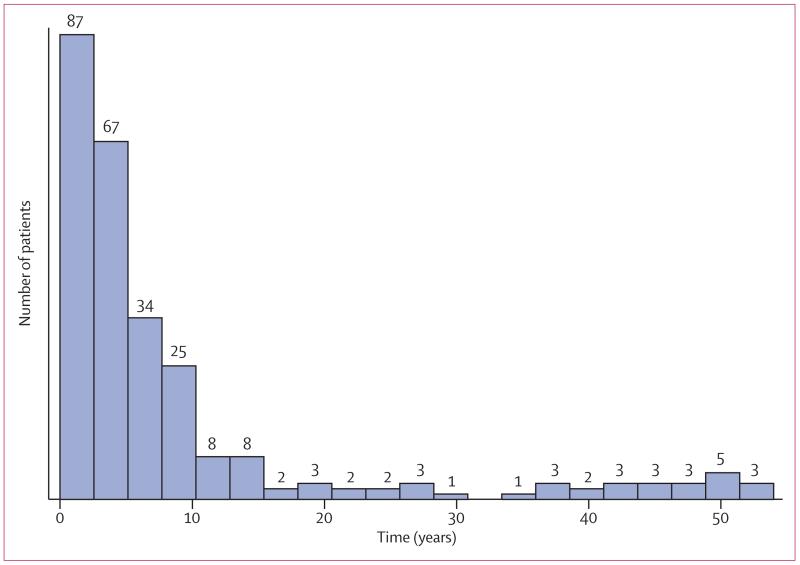
Time interval between entry to the UK and diagnosis of tuberculosisData for year of entry to the UK were not available for 12 patients.